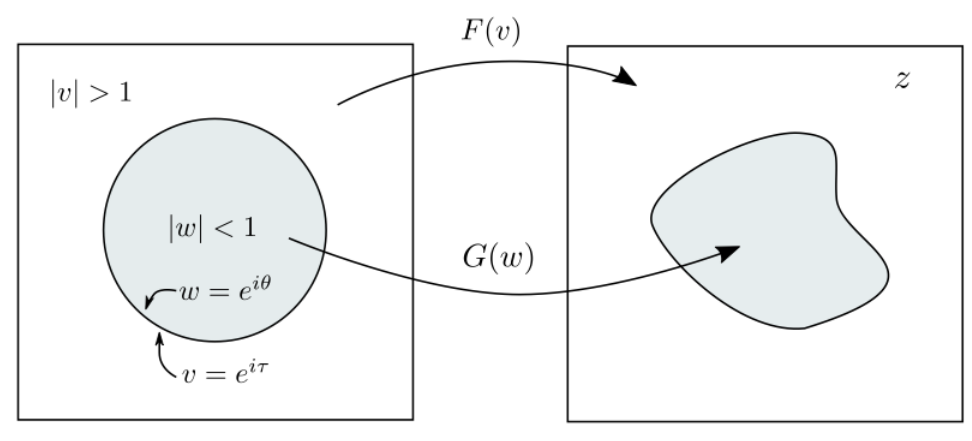
Figure 10 . The conformal welding problem. We are given two disks, one parametrized by j w j (cid:20) 1 and another by j v j (cid:21) 1 with their boundaries glued in terms of a given function (cid:18) ( (cid:28) ) where w = e i(cid:18) and v = e i(cid:28) . Then we need to (cid:12)nd holomorphic maps of each disk to a region of the complex z plane so that they are compatible at the boundary. The functions F and G are only required to be holomorphic inside their respective